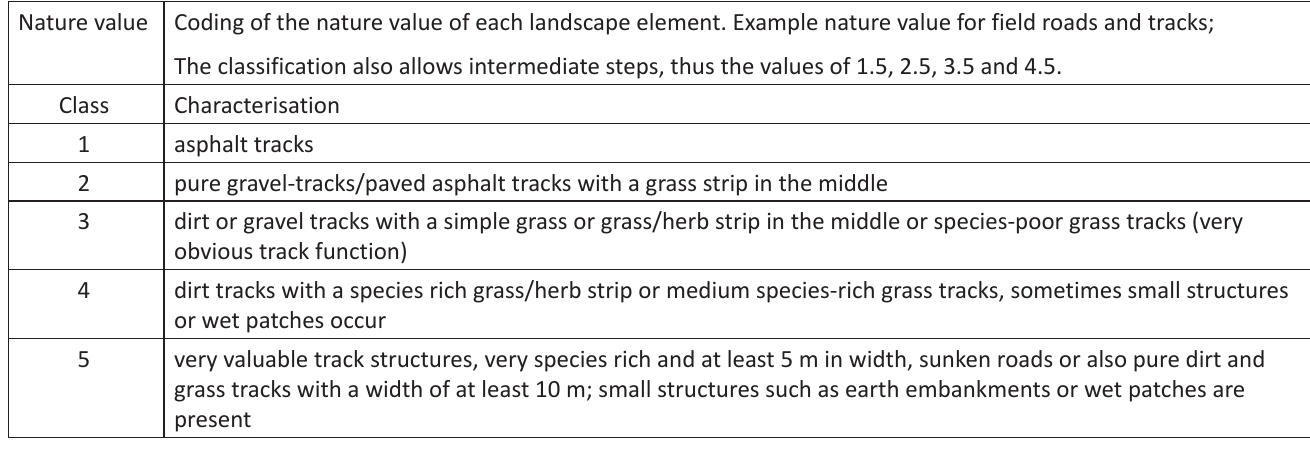
Table 2d. Description of the nature value for one type of landscape elements (field roads and tracks).